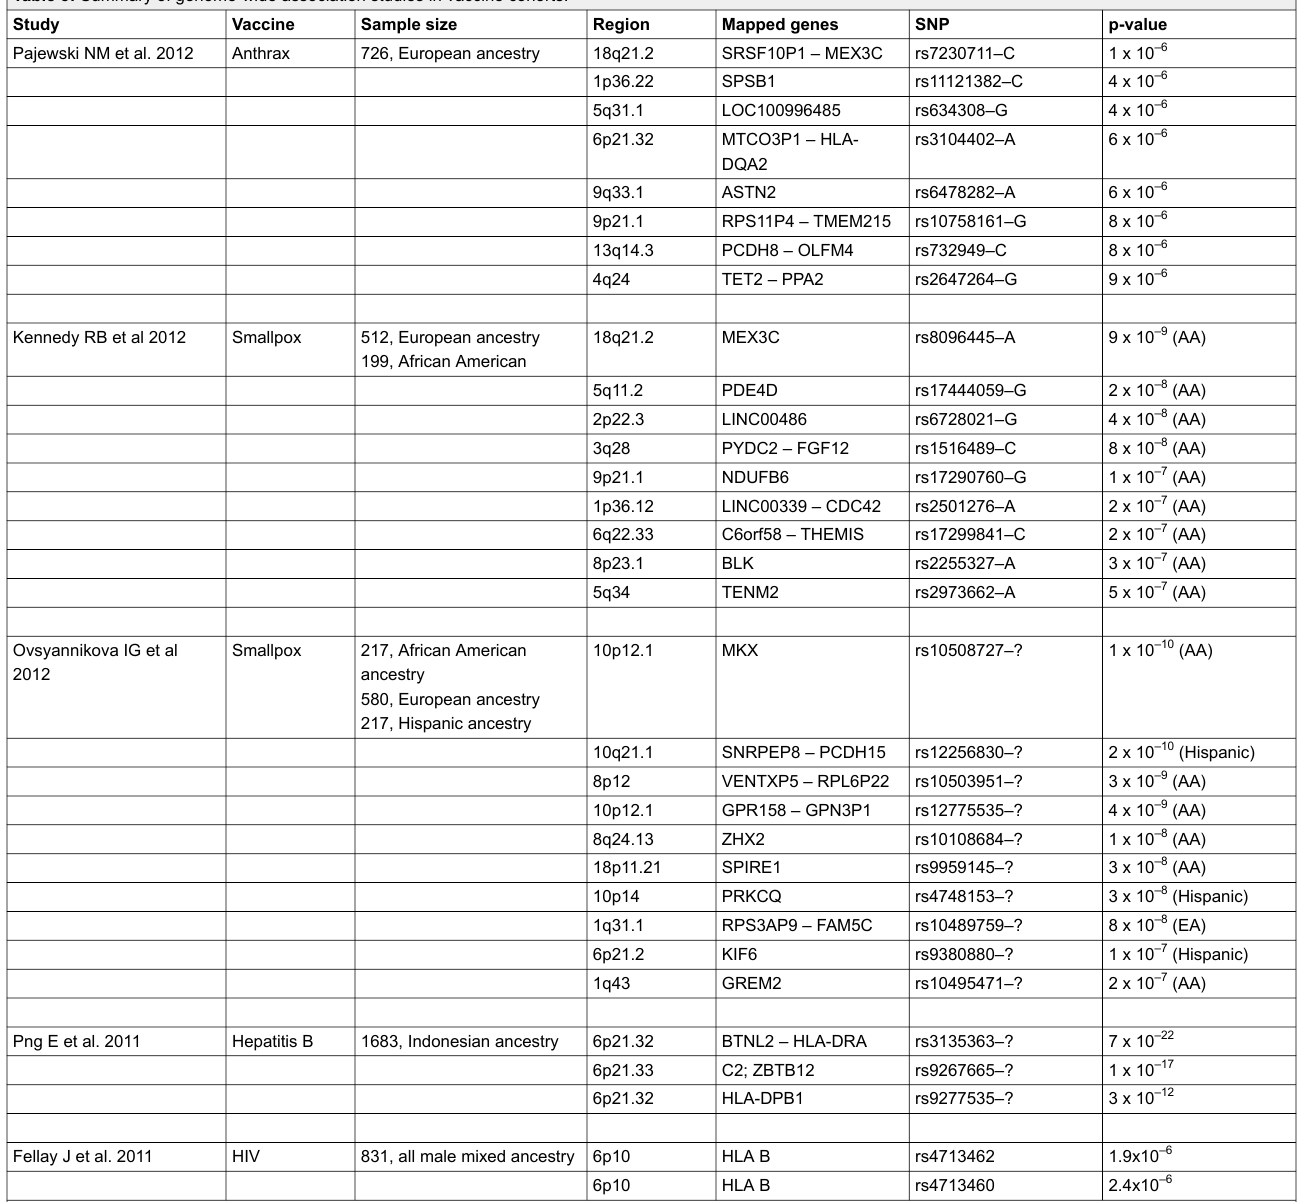
Table 3: Summary of genome-wide association studies in vaccine